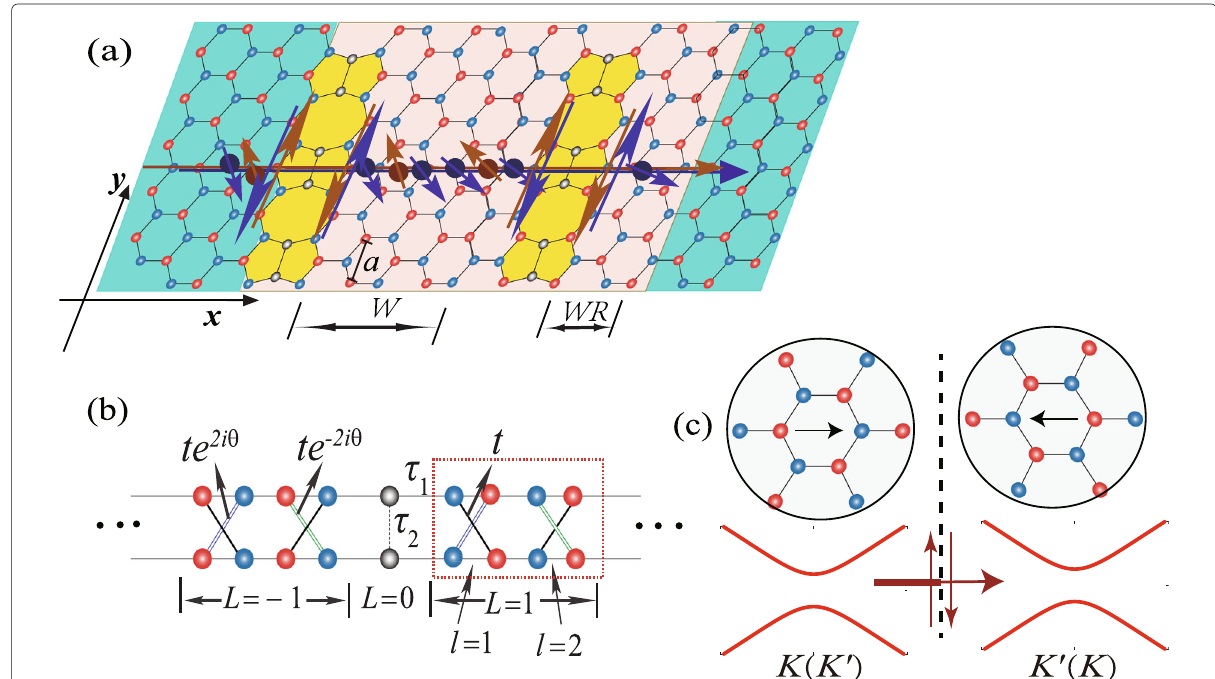
Fig. 1 a Schematic diagram of the precession process of the states ( K , ↑ ) (red sphere) and ( K (cid:2) , ↓ ) (blue sphere) through a silicene sheet with two parallel line defects, where the blue (red) circle denotes the A ( B ) sublattice. The states ( K , ↑ ) and ( K (cid:2) , ↓ ) circulate along the pseudo-edge, and the RSOC as well as electric field is assumed to exist on the french grey region. W ( W = 2 ) and WR ( WR = 1 ) represent the width of the scattering region √ 3 a . b The simplifed lattice model of the infnite silicene with a line defect, where θ = k y a and the dotted rectangle corresponds to a in units of supercell. In the unit cell, the lattice points are specified by a set of indices ( L , l ) . c The transmission for one spin state in the K ( K (cid:2) ) valley across line defect with inversion domain boundaries. The insets show the orientation of the crystalline lattice in the two domains separated by the line defect (dashed line). The thick/thin lines indicate that the transmission is restrained across the line defect due to the helical edge states flowing inversely along the